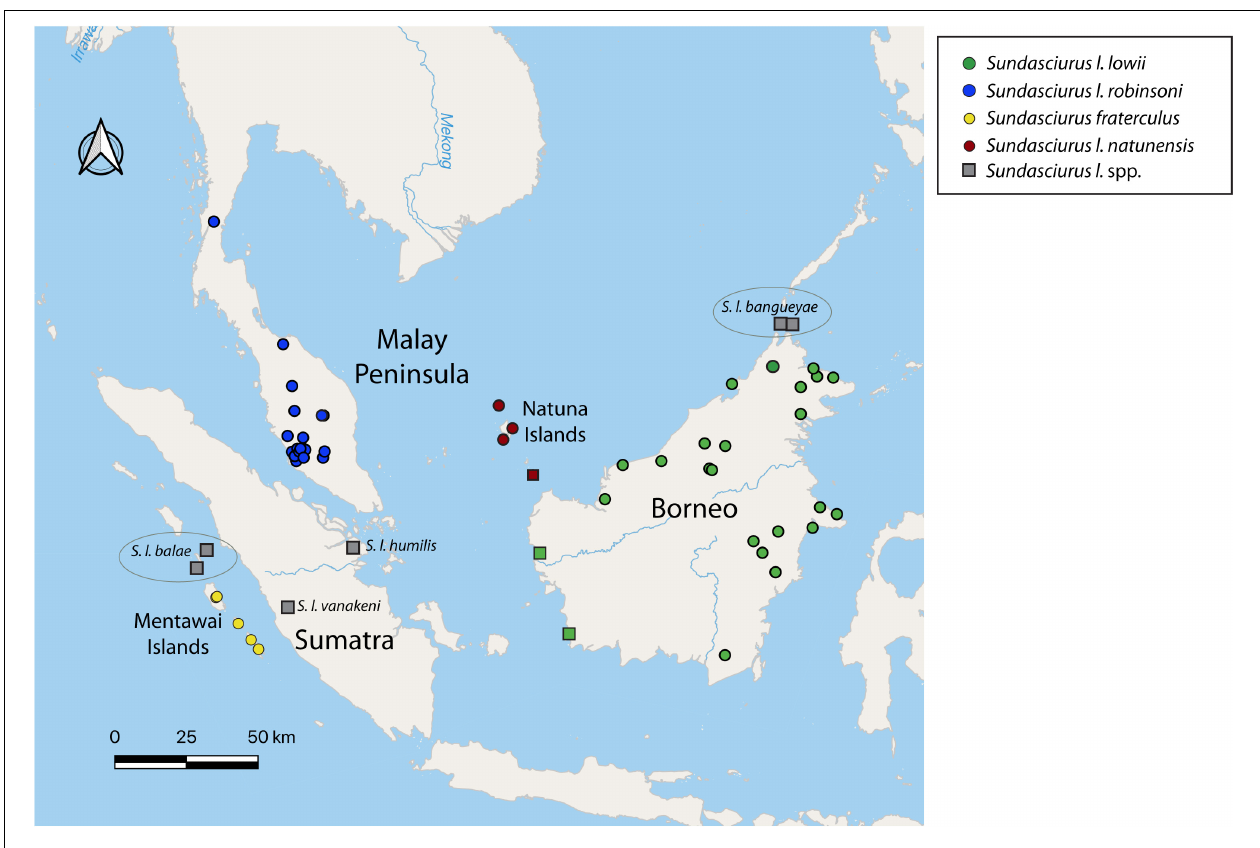
FIGURE 1 | Map of Sundaland showing the distribution of the different subspecies of the Low-Fraternal squirrel species complex, with dots indicating sample collection locations of specimens included in the morphometric analyses. Samples are colored according to the four highly supported major clades recovered in the mitogenome-based phylogenies of Figures 2 , 3 . Populations indicated by a red circle have been considered S. l. natunensis but the morphological data in this study suggests they are more similar to S. l. lowii . Populations indicated with a green square have been considered S. l. lowii but the morphological data in this study suggests these they are more similar to S. l. natunensis . Molecular evidence from these populations is needed to clarify their taxonomic status. Populations included in the morphological analyses but not the genetic analyses are indicated in